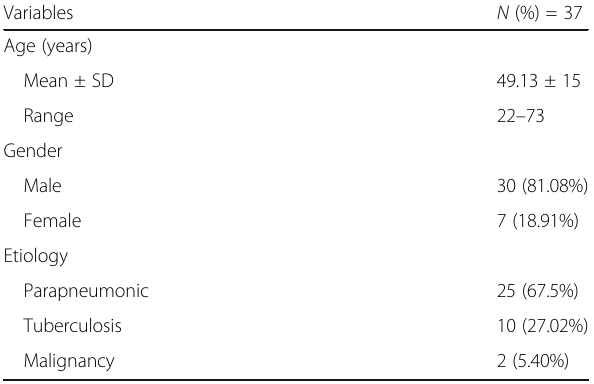
Table 1 Sociodemographic data and etiology of pleural infection in the studied patients ( n = 37)